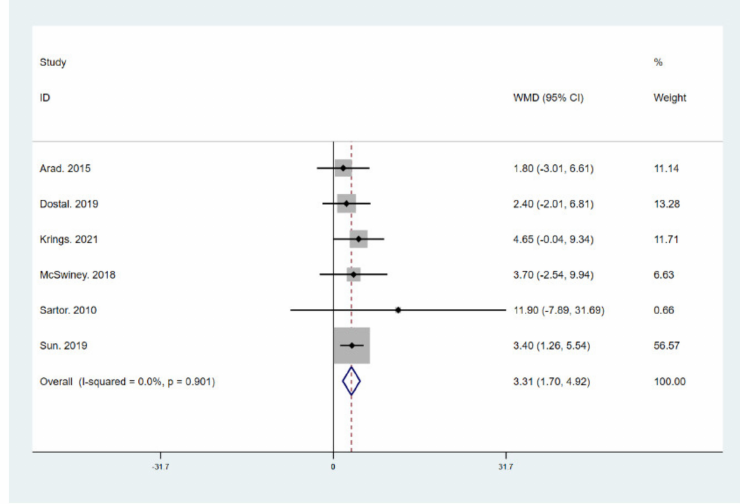
Figure 7. Forest plot for the effect of a low-carbohydrate high-fat (LCHF) diet combined with HIIT on maximal oxygen uptake (VO 2 max). For each study, squares represent the mean difference in intervention effects, with horizontal lines intersecting them as the lower and upper limits of the 95% CI. The size of each square represents the relative weight of the studies conducted in the meta-analysis. The diamond represents the results of the meta-analysis combining the individual studies.